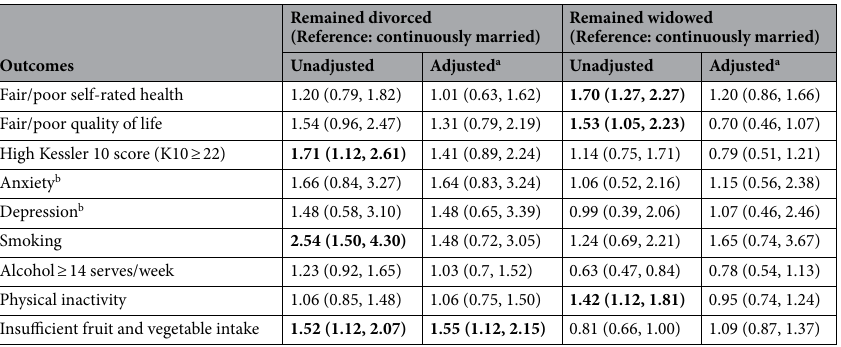
Table 5. Odds ratios for the associations of marital disruption which occurred between T1 (2006–2009) and T2 (2010) with health-related outcomes at T3 (n = 21,605). T1: baseline data collection (2006–09); T2: first follow-up: 2010; T3: second follow-up: 2012–16. Boldface indicates statistical significance at p < 0.05. Continuously married: married at T1, T2 and T3; Remained divorced: married at T1 and divorced/separated at T2 and T3; Remained widowed: married at T1 and widowed at T2 and T3. a Adjusted for the outcome